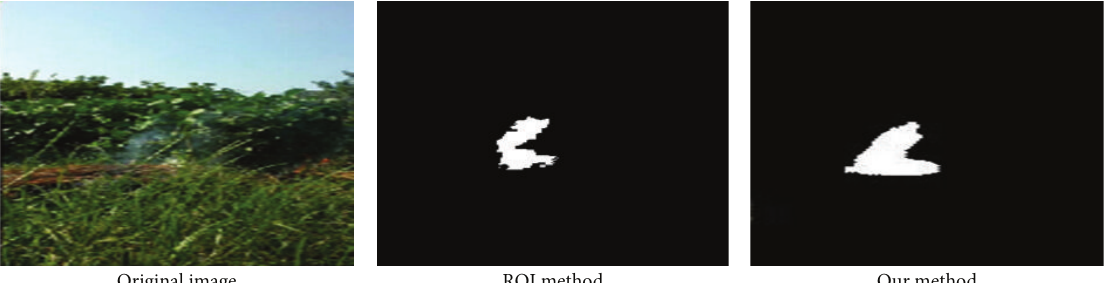
Figure 5: Smoke region extraction of low concentration.